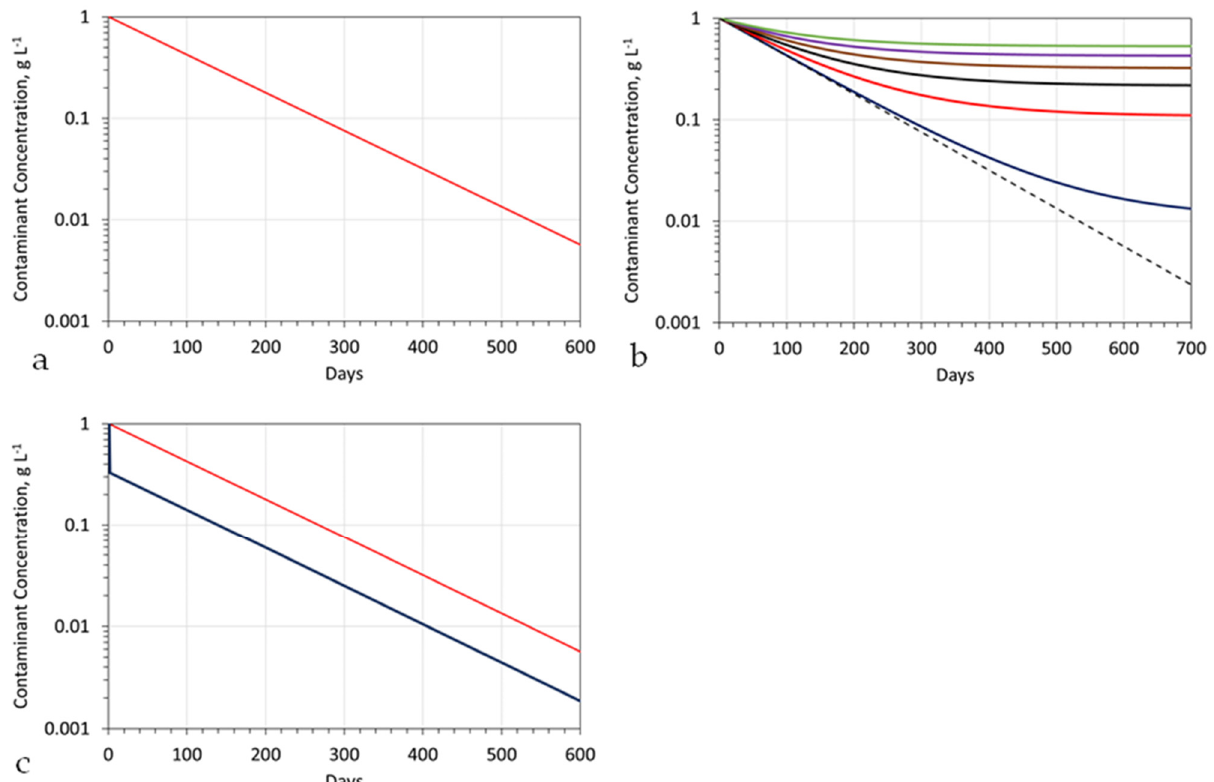
Figure A2. Example pollutant concentration in a stationary plume as a function of processing time, for B = 960 m 3 d − 1 : Stationary Plume details as per Table A1. Initial contaminant concentration = 1 g L − 1 ; ( a ), pollutant concentration versus time for A = 0; plume Type = Figure A1c; ( b ), pollutant con- centration versus time for black dashed line: A = 0 m 3 d − 1 ; blue line: A = 10 m 3 d − 1 ; red line: A = 100 m 3 d − 1 ; black line: A = 200 m 3 d − 1 ; brown line: A = 300 m 3 d − 1 ; purple line: A = 400 m 3 d − 1 ; green line: A = 500 m 3 d − 1 ; plume Type = Figure A1c; ( c ), pollutant concentration versus time for A = 0; blue = contaminant plume volume is 33% of the stationary plume volume; red = contaminant plume vol- ume is 100% of the stationary plume volume; plume type = Figure A1b; dilution of the stationary plume by a water volume, (which is less than the abstracted water/reinjected water volume, assum- ing 95% remediation) will show a similar relationship between contaminant concentration and pro- cessing days.